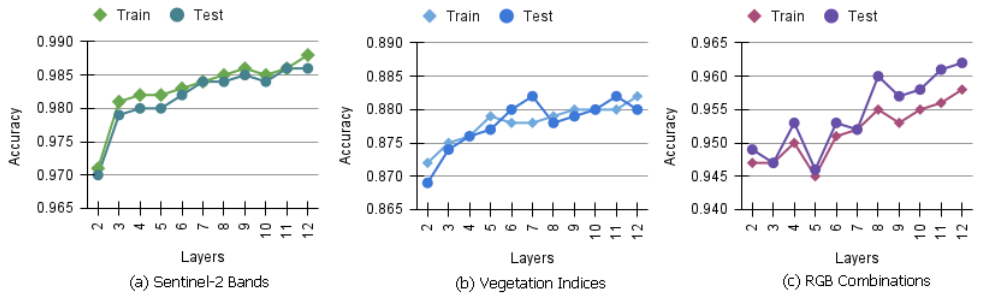
Figure 5. Evaluation of the dense neural network model according to the number of hidden layers added for bands, vegetation indices, and RGB